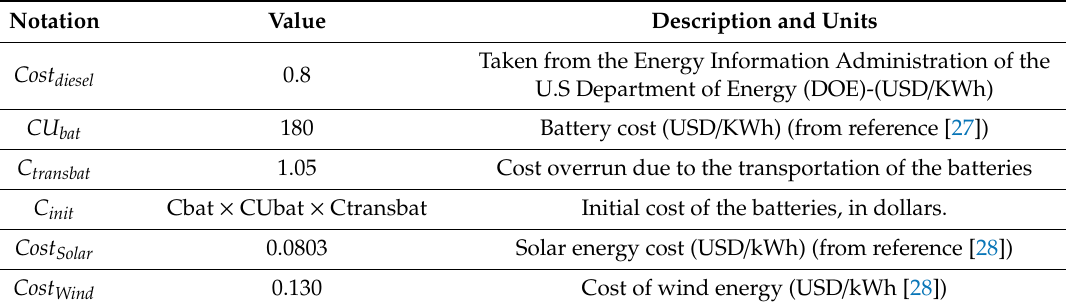
Table 4. Costs (for F 1 ( x ), F 2 ( x ), F 3 ( x ), and F 4 ( x )